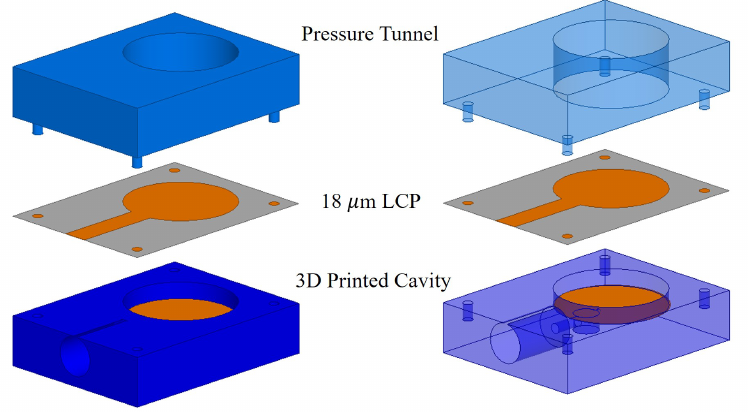
Figure 3. Exploded view of 3D printed pressure sensor with three main